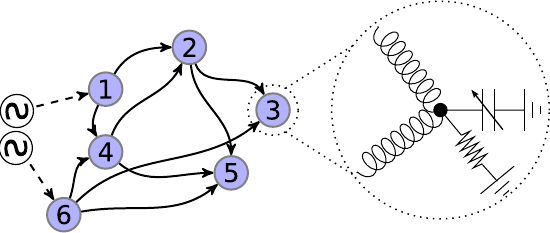
Figure 4. An example of a nonlinear electrical network. In the graph on the left, the numbered circles are nodes, the solid arrows are edges, and the dashed arrows are half-edges. Orientation of the arrows indicates the direction of positive current flow. Each node corresponds to a voltage-dependent capacitor to ground, wired in parallel with a resistor to ground, as depicted in the zoomed-in schematic for node 3 . Each edge corresponds to an inductor. Each half-edge connects one prescribed voltage source to one given node. In this paper, all methods that are developed are valid for connected graphs with at least one half-edge. Note that the circuits in Figures 1–3 can all be represented using this graph